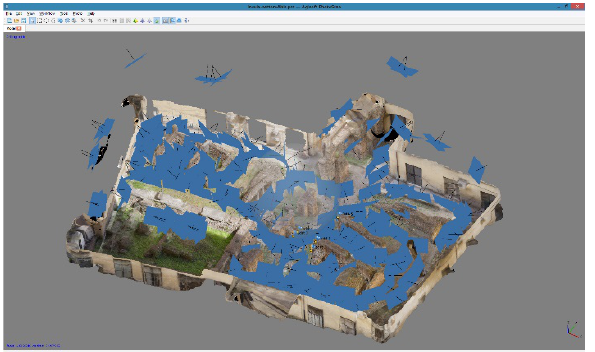
Fig. 19 A geometric detail of a image-based 3D model of late antique strata, visualized as colour mode.